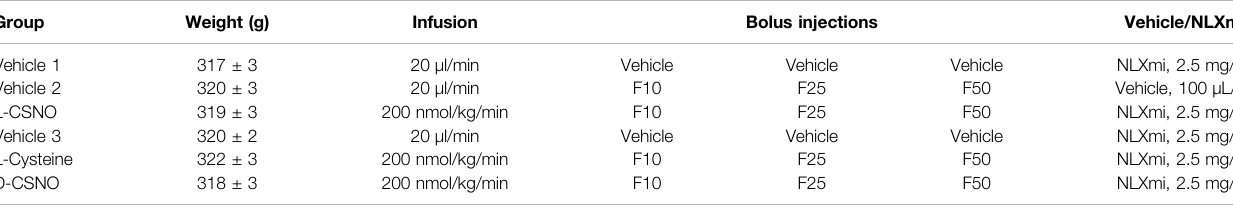
TABLE 1 | Description of the six treatment groups used in the whole body plethysmography experiments.